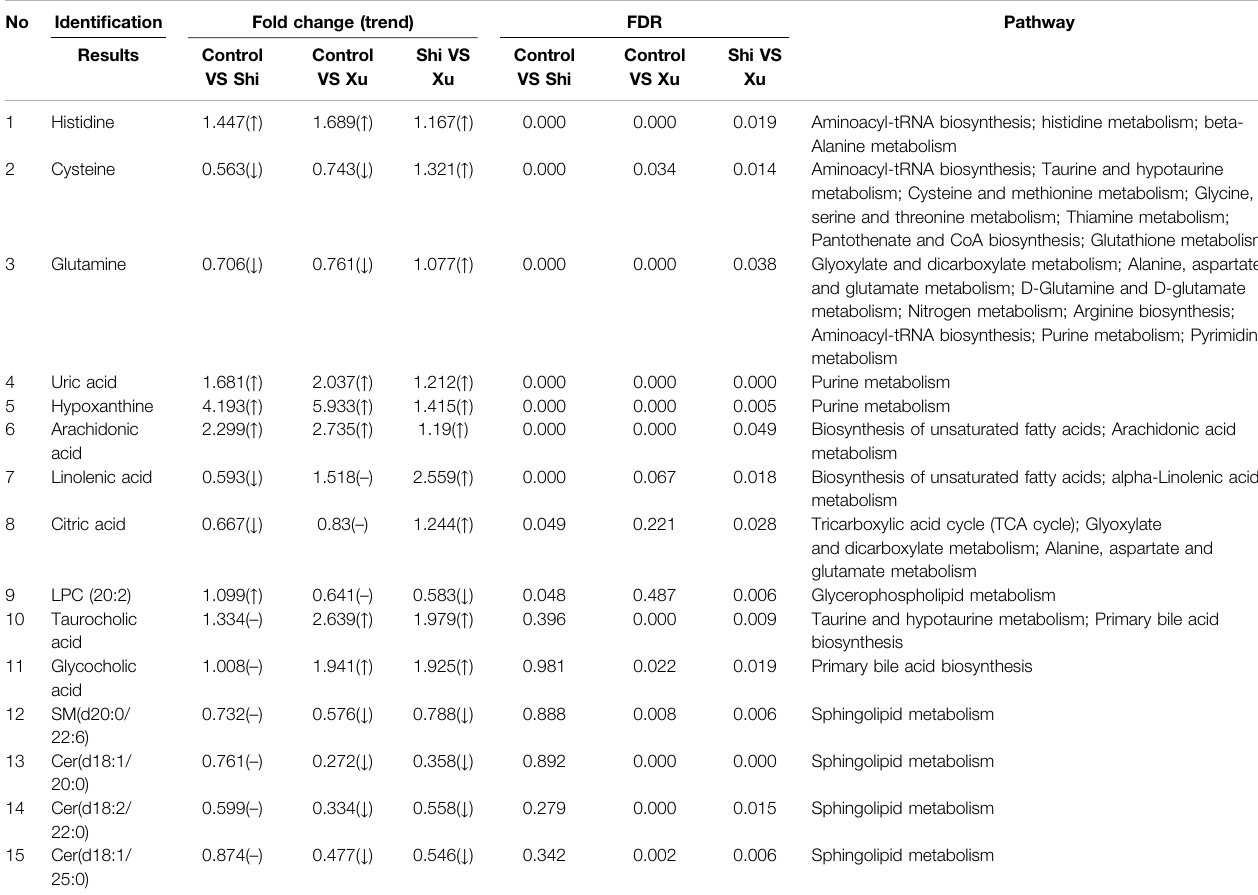
TABLE 2 | Identi fi cation of potential biomarkers in